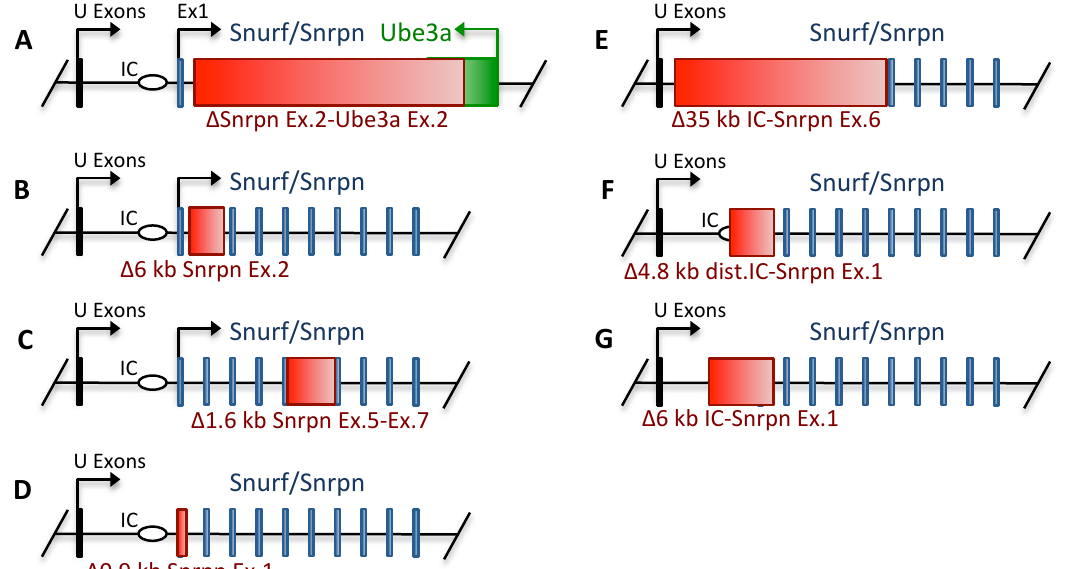
Figure 2. Schematic representation of genetically engineered mouse models harboring deletions within Snurf/Snrpn and PWS IC center (drawings are not to scale). Green and thin blue rectangles denote Ube3a and Snurf/Snrpn CDS exons, respectively. The red rectangles indicate generated genomic deletions. Thin black rectangles show location of U-exons; the imprinting center (IC) is denoted by a horizontal oval. ( A ). Large deletion of the genomic region between Snurf/Snrpn exon 2 and Ube3a exon 2. [41]. ( B ). Inactivation of the Snurf ORF by deleting the 6 kb region including Snurf/Snrpn